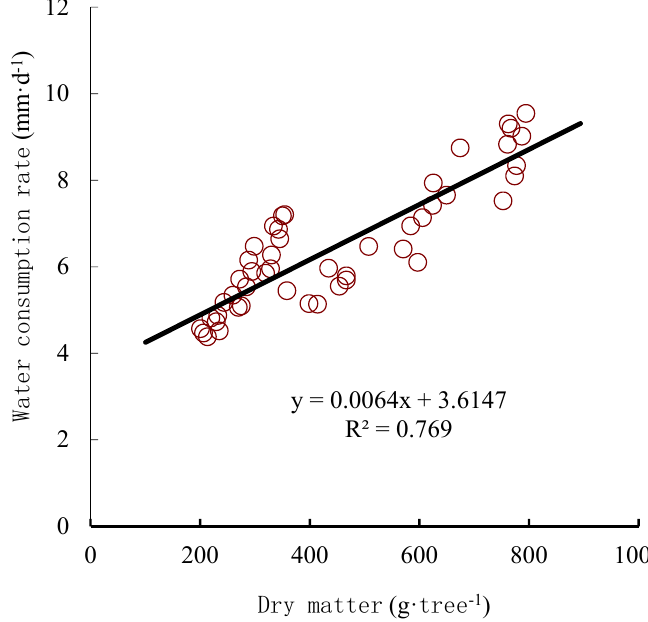
Figure 9. Relationship between water consumption rate and dry matter of young apple trees (R 2 = 0.769, n = 48).